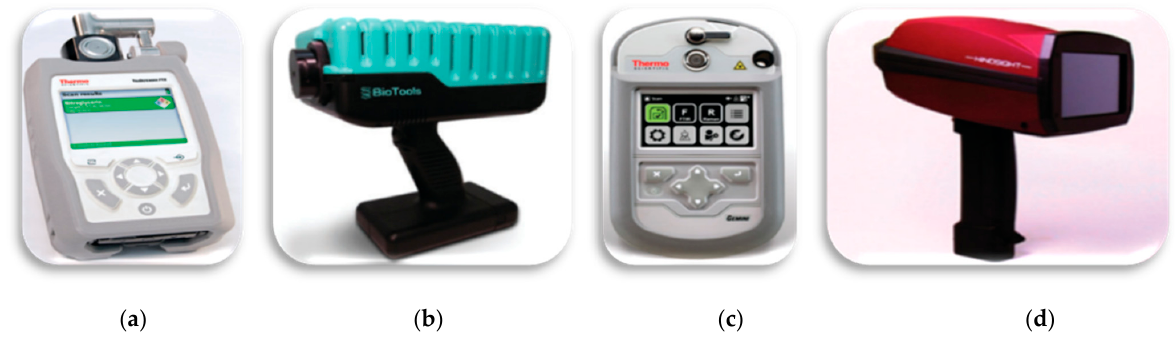
Figure 7. Portable devices: ( a ) FTIR—Thermo Fisher Scientific; ( b ) Raman—BioTools RamTest; ( c ) Gemini-combined Raman and FT-IR handheld analyzer—Thermo Fisher Scientific; ( d ) HI-BaySpec’s GoldenEye. Reprinted from Applied Spectroscopy , 72, Crocombe, R.A. Portable Spectroscopy, 1701–1751. [69], Copyright (2018), with permission from SAGE